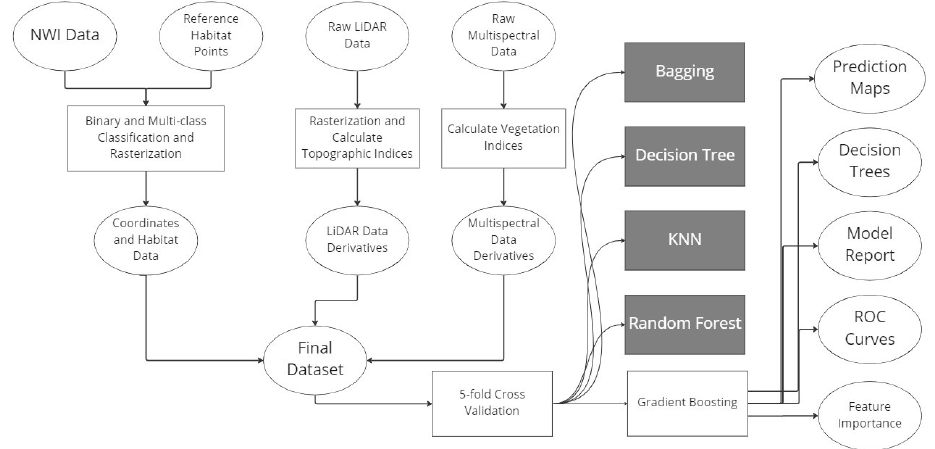
Figure 2. Workflow showing data preprocessing steps as well as the inputs and outputs of the Gra- dient Boosting models in addition to some other models tried (shown in grey and not used in anal- ysis).